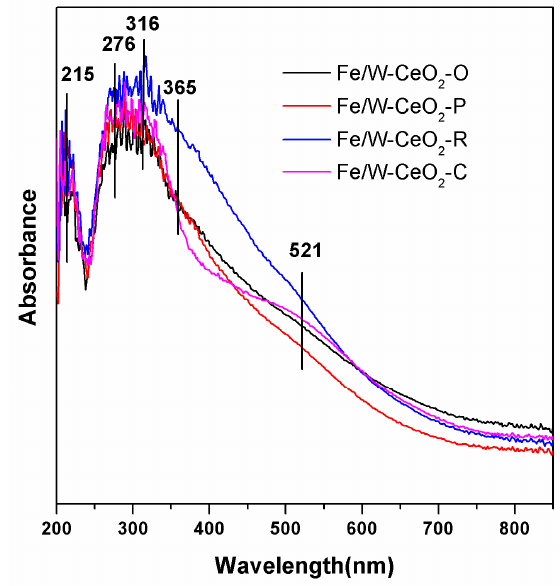
Figure 6. UV–VIS of Fe/W–CeO 2 catalysts.